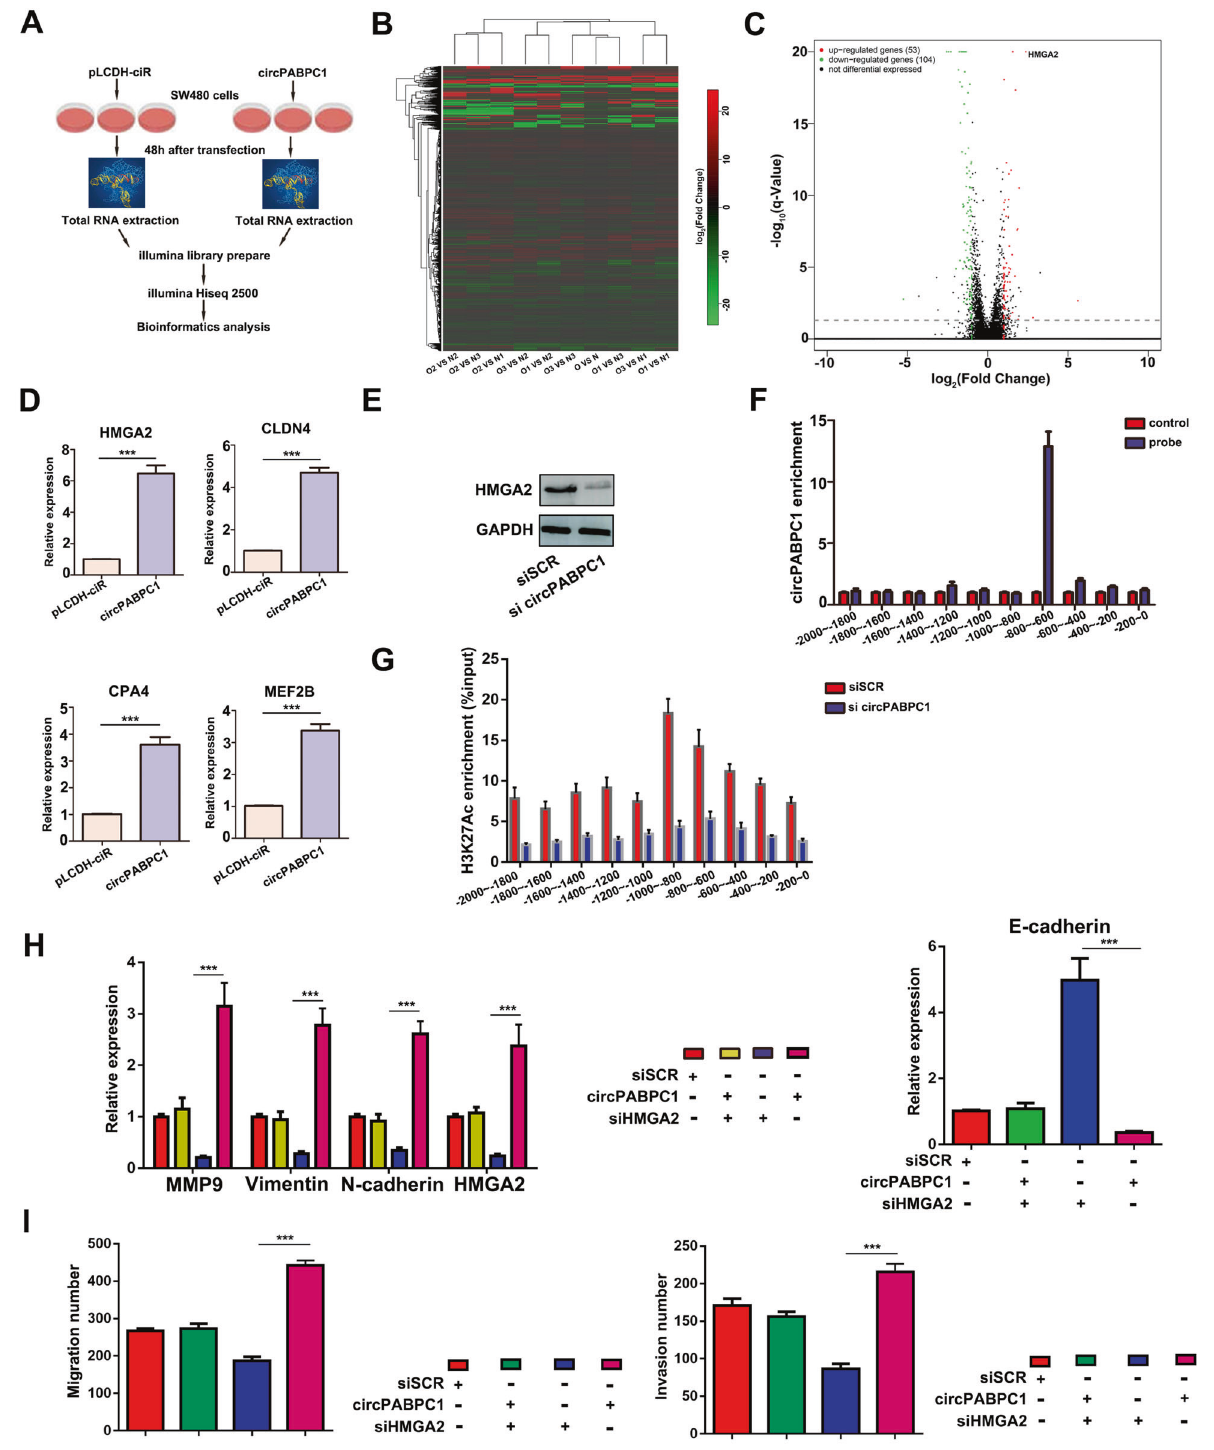
Fig. 3 CircPABPC1 increases HMGA2 expression and regulates EMT progression in CRC. A Schematic illustration showing the details of circPABPC1 overexpression and RNA-seq. B , C Cluster heatmap and volcano map showing the differentially expressed genes after circPABPC1 overexpression in CRC cells. D The expression of four potential target genes was validated by qRT – PCR after circPABPC1 overexpression. E The protein level of HMGA2 was detected by western blot assay after circPABPC1 knockdown. F The enrichment of circPABPC1 on the promoter of HMGA2 was detected by CHIRP using circPABPC1-speci fi c biotin-labeled probes. G The enrichment of H3K27Ac modi fi cation on the promoter of HMGA2 was detected by ChIP assay in CRC cells after circPABPC1 knockdown. H The protein levels of EMT-related genes were detected by western blot analysis. I The effect of circPABPC1 and HMGA2 on cell invasion was measured by cell migration and invasion assays. Quantitative data from three independent experiments are shown as the mean ± SD (error bars). * P < 0.05, ** P < 0.01, *** P < 0.001 (Student ’ s t test).